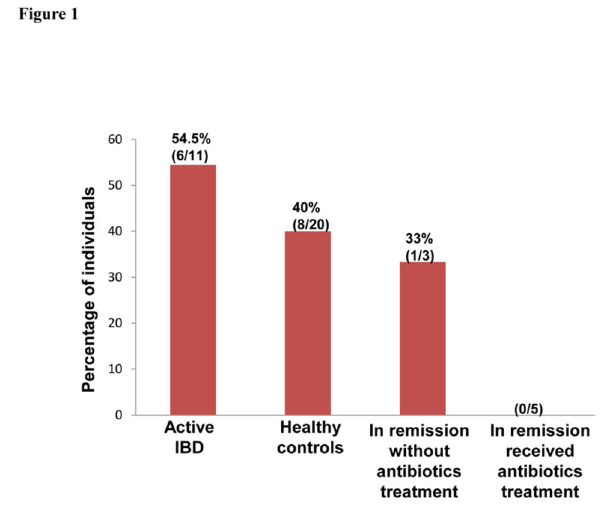
the oral cavity of patients with IBD and controls. The healthy controls was not statistically different. zot -positive